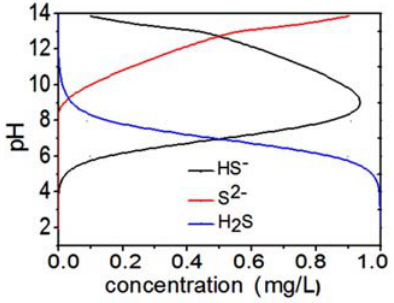
S in various pH media. 2